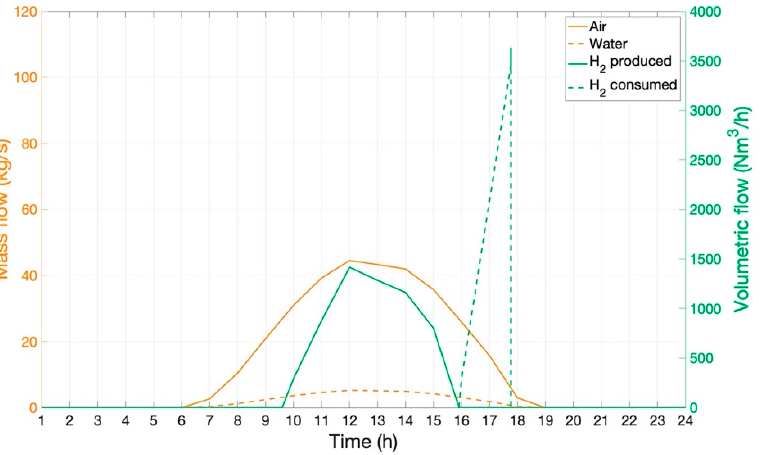
Figure 8. Instantaneous mass flow changes for the ISCC power plant with the hydrogen system.